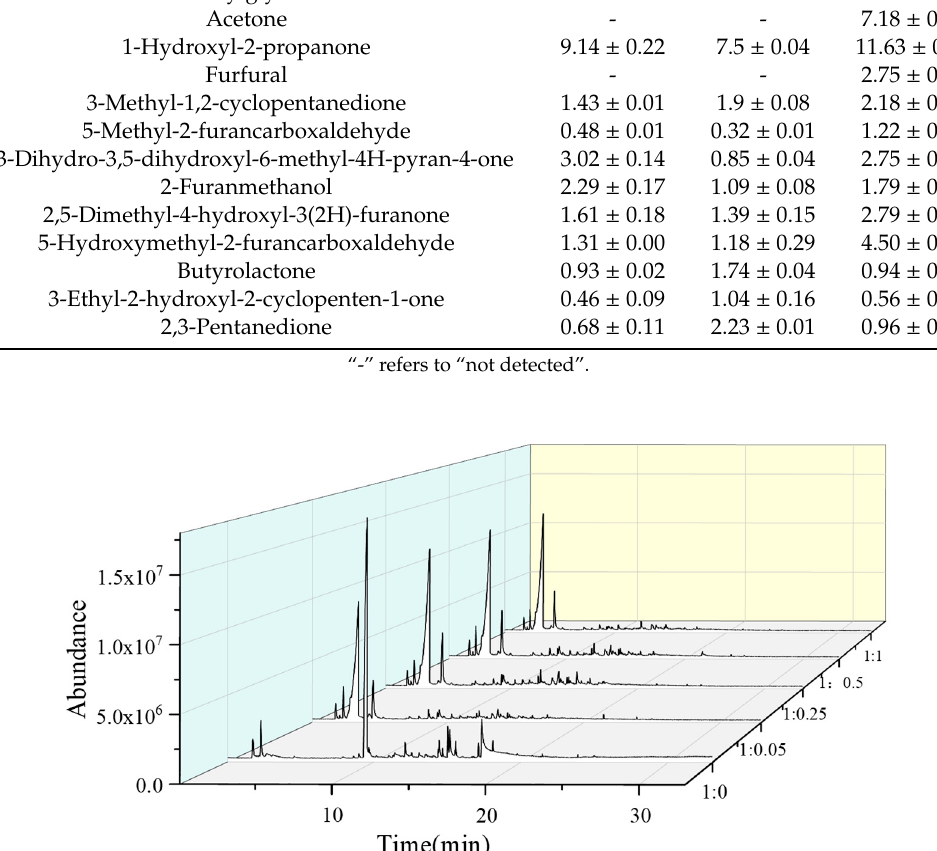
Table 7. Peak area (%) of the typical products derived from the fructose in situ catalytic pyrolysis at 350 °C with the different fructose /KAc ratios. Products